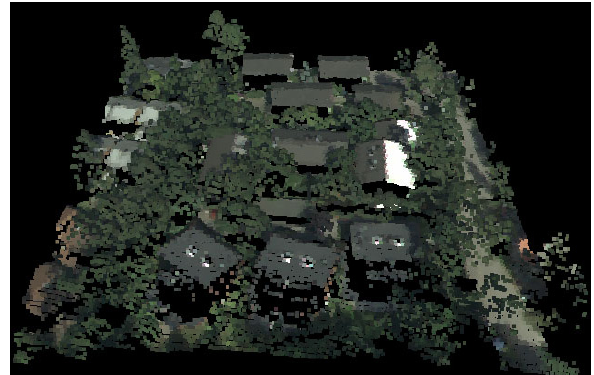
Figure 5. The colorized ALS point cloud. The relative orientation was based on using only NTFs.